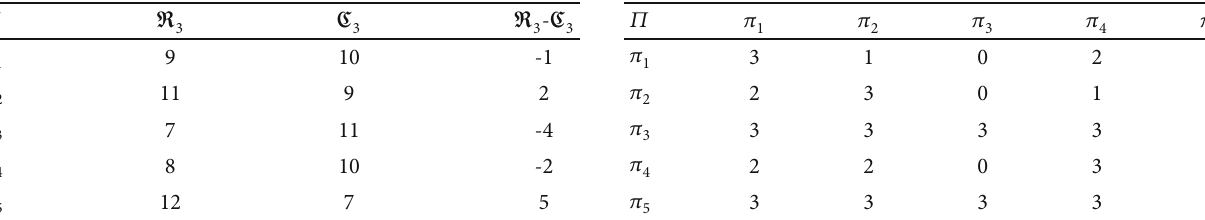
Table 14: The comparison table of Table 11.